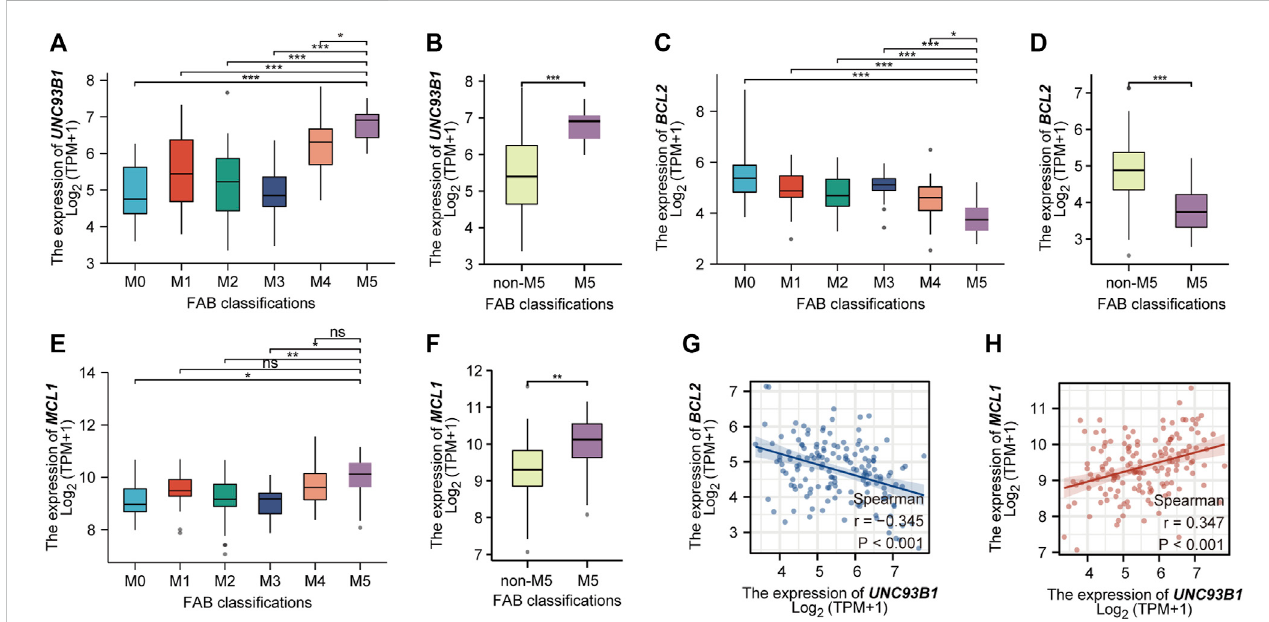
FIGURE 7 High expression of UNC93B1 in FAB-M5 AML and association with losing expression of venetoclax target BCL2. (A) The expression level of UNC93B1 in differentFABsubtypes(M0-M5)ofAML.M6andM7wereexcludedbecauseofsmallnumbers( n ≤ 3). (B) Theexpressionlevelof UNC93B1 inFAB-M5AMLand non-M5 AML. non-M5 including M0, M1, M2, M3, M4, M6 and M7 of FAB classi fi cation. (C) The expression level of BCL2 in different FAB subtypes (M0-M5) of AML. (D) The expression level of BCL2 in FAB-M5 AML and non-M5 AML. (E) The expression level of MCL1 in different FAB subtypes (M0-M5) of AML. (F) The expression level of MCL1 in FAB-M5 AML and non-M5 AML. (G) The negative correlation of UNC93B1 expression and BCL-2 expression in AML. (H) The positive correlation of UNC93B1 expression and MCL1 expression in AML. (r means Spearman ’ s correlation coef fi cient. Wilcoxon rank sum test was